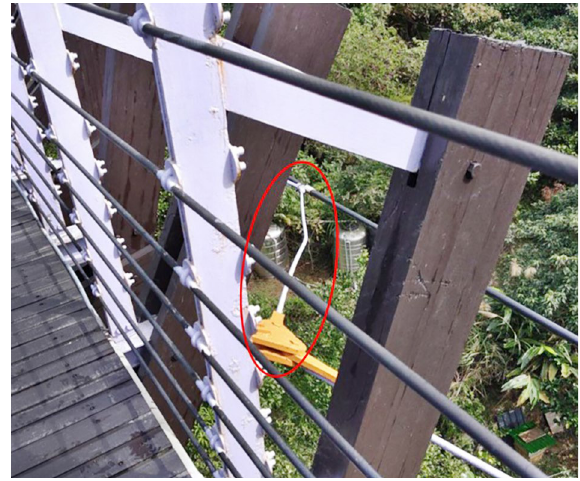
Figure 4. One of the buckled and rusted steel connecting rods